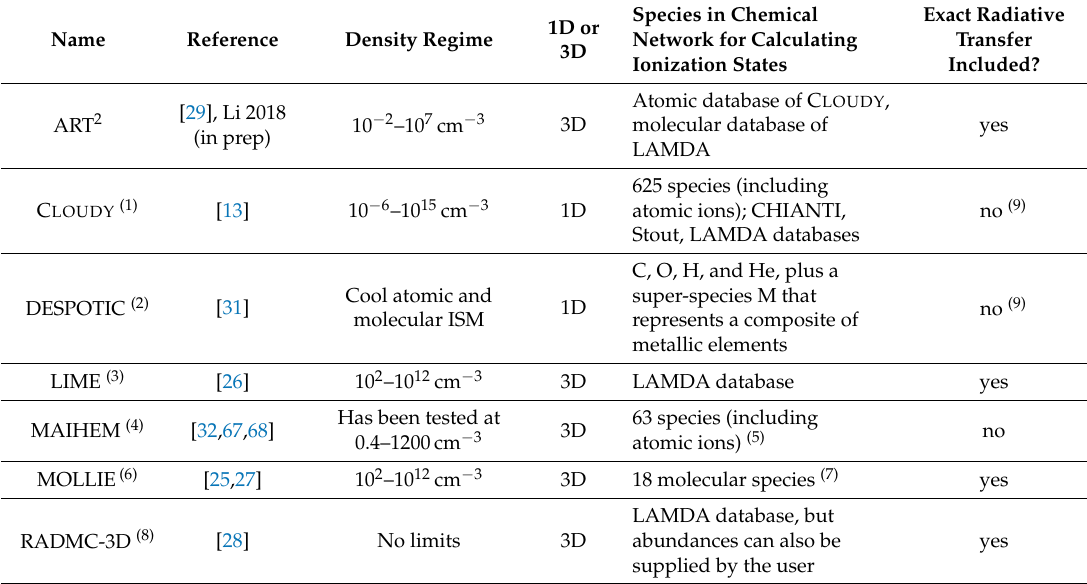
Table 2. Overview of the computational tools represented at the